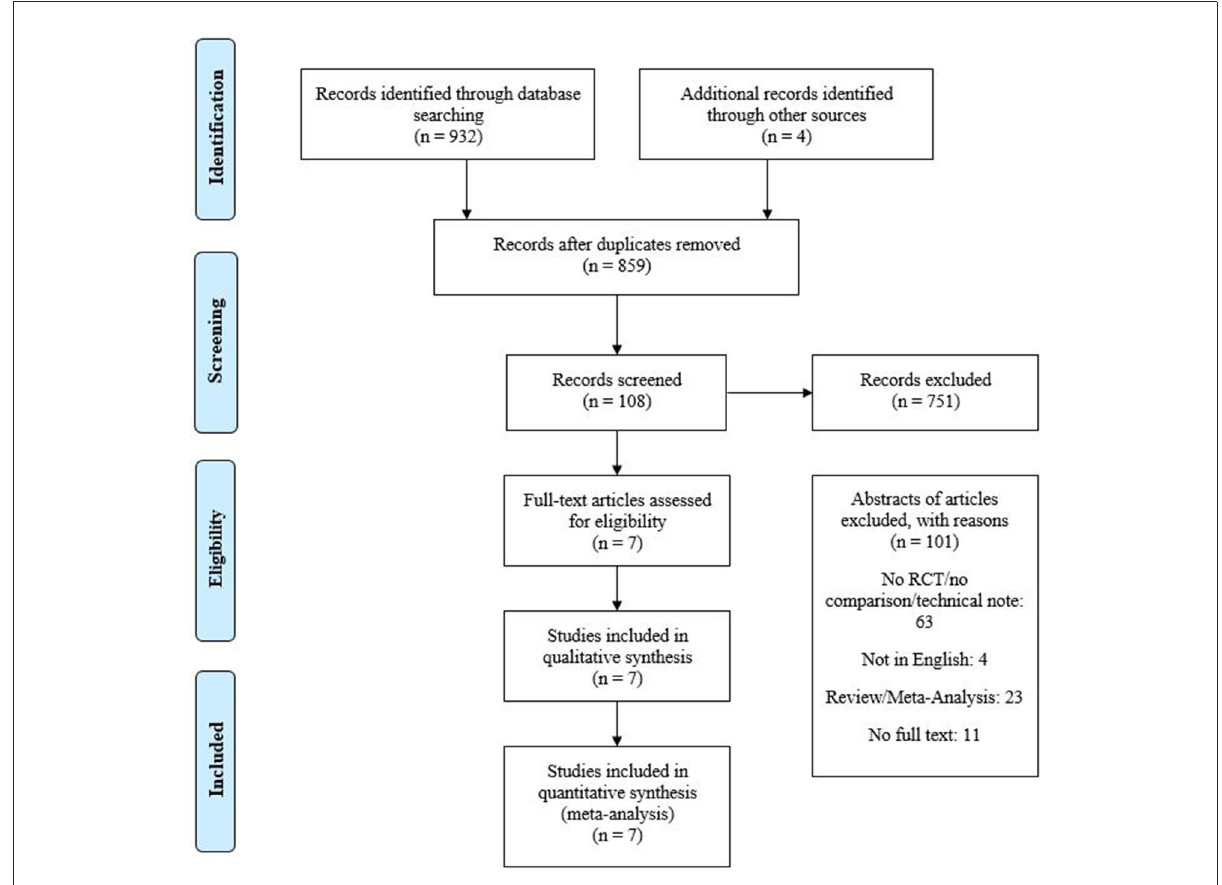
FIGURE1 Flowchart of the study selection process according to the PRISMA